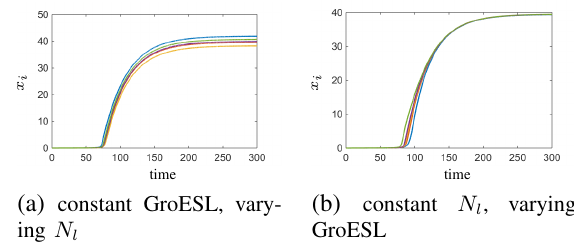
Fig. 8: Time course of the intracellular AHL- concentration of ten cells within one colony influenced by GroESL and Regulator n l